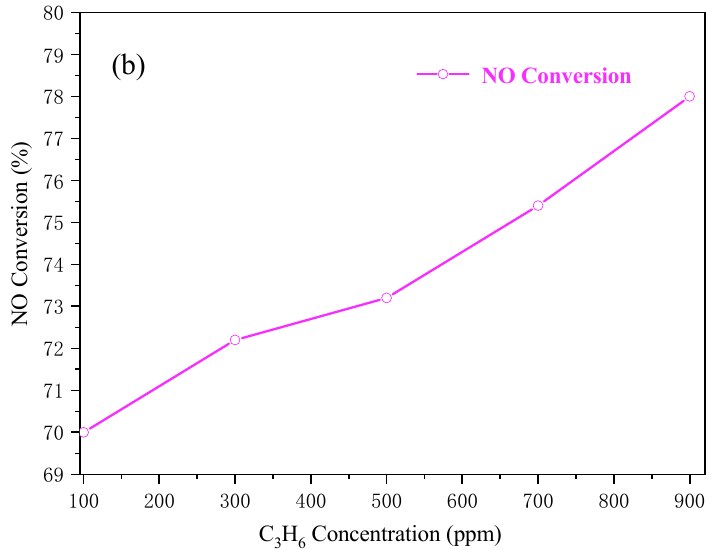
Figure 12. ( a ) The C 3 H 6 -SCR performance of Cu-SAPO-34 catalyst, reaction condition: 500 ppm NO, 500 ppm C 3 H 6 , 10% O 2 , and N 2 as balance gas. GHSV = 36,000 h − 1 . ( b ) The NO x conversion as a function of C 3 H 6 concentration at 500 °C. (C 3 H 6 concentration = 100, 300, 500, 700, and 900 ppm).